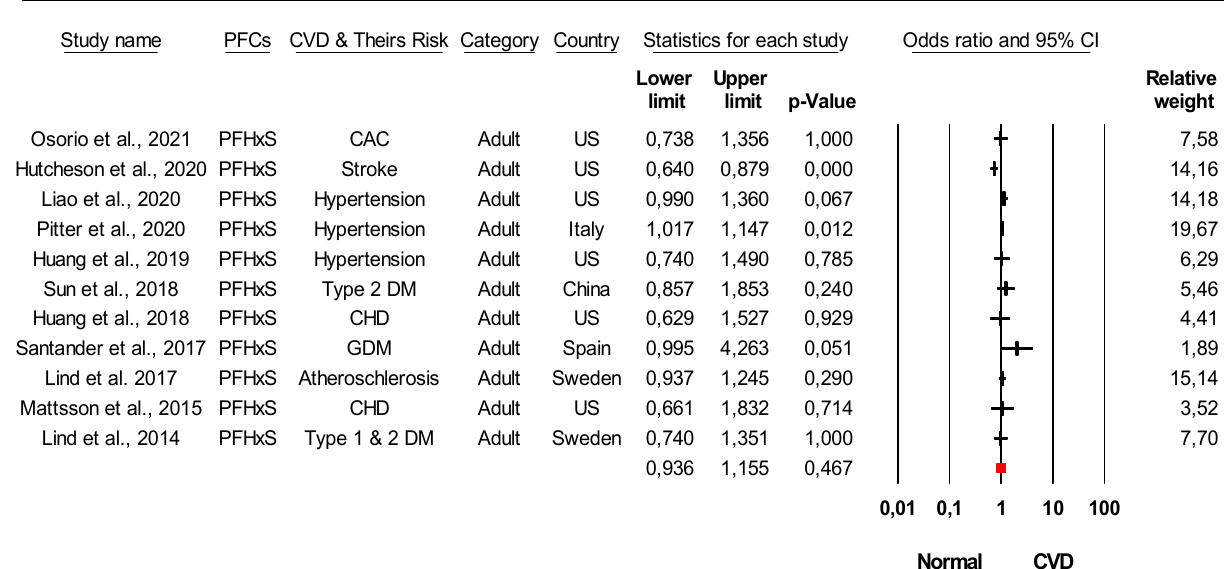
Figure 5. Meta-analysis of studies of PFHxS exposure and CVDs and their risk using the random-effects model, ordered by date of publication. Stratified analysis of PFHxS as the unit of analysis within the study was selected. CAC = coronary artery calcium, DM = diabetes mellitus, GDM = Gestational Diabetes Mellitus, CHD = coronary heart diseases. Test for overall effect: z = 0.73, p = 0.47; Test for heterogeneity: I 2 = 58.56% Q = 24.13 df = 10, p = 0.007.